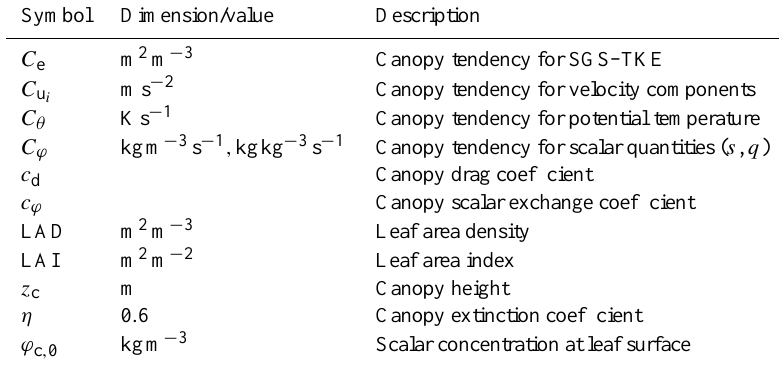
Table 6. List of canopy model parameters and